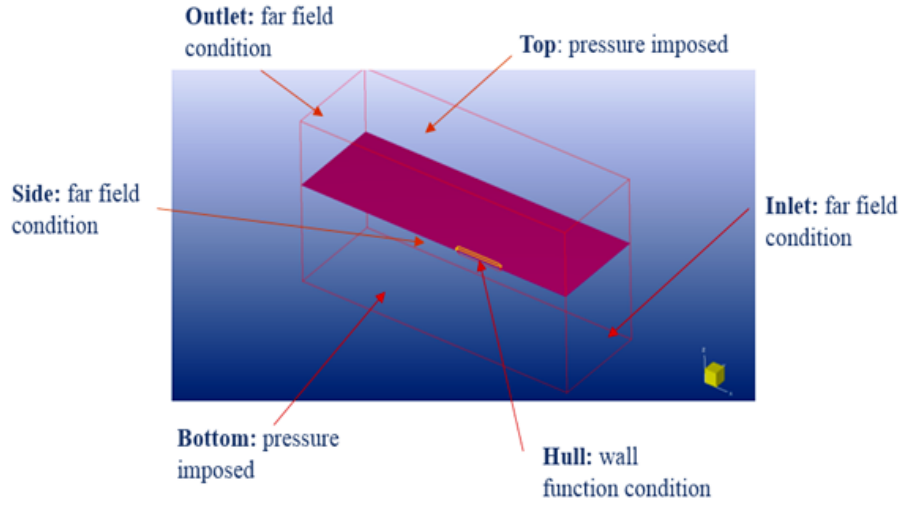
Figure 2. DTC—domain and boundary conditions.